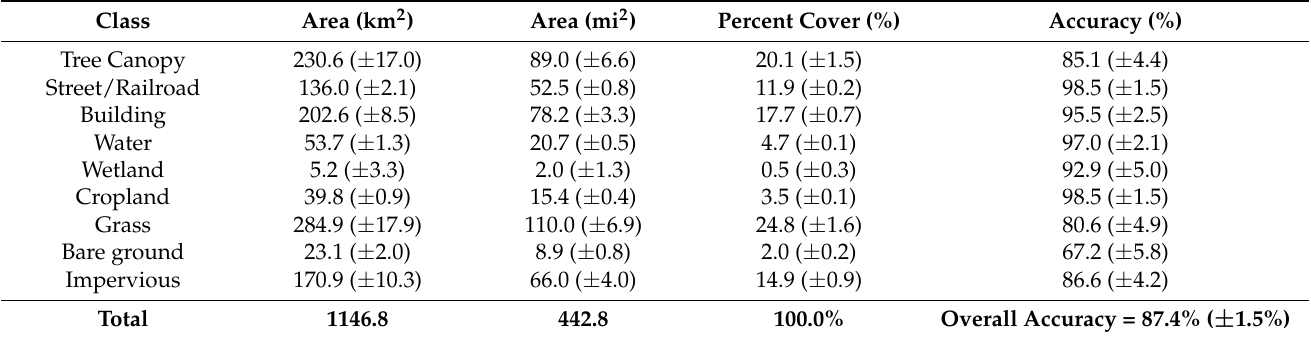
Table 3. Area, percent cover, and user’s accuracy of land cover classes and their standard error (SE) estimates (SE * ( ± 1.96) provides 95% confidence intervals). Area and percent cover are accuracy adjusted